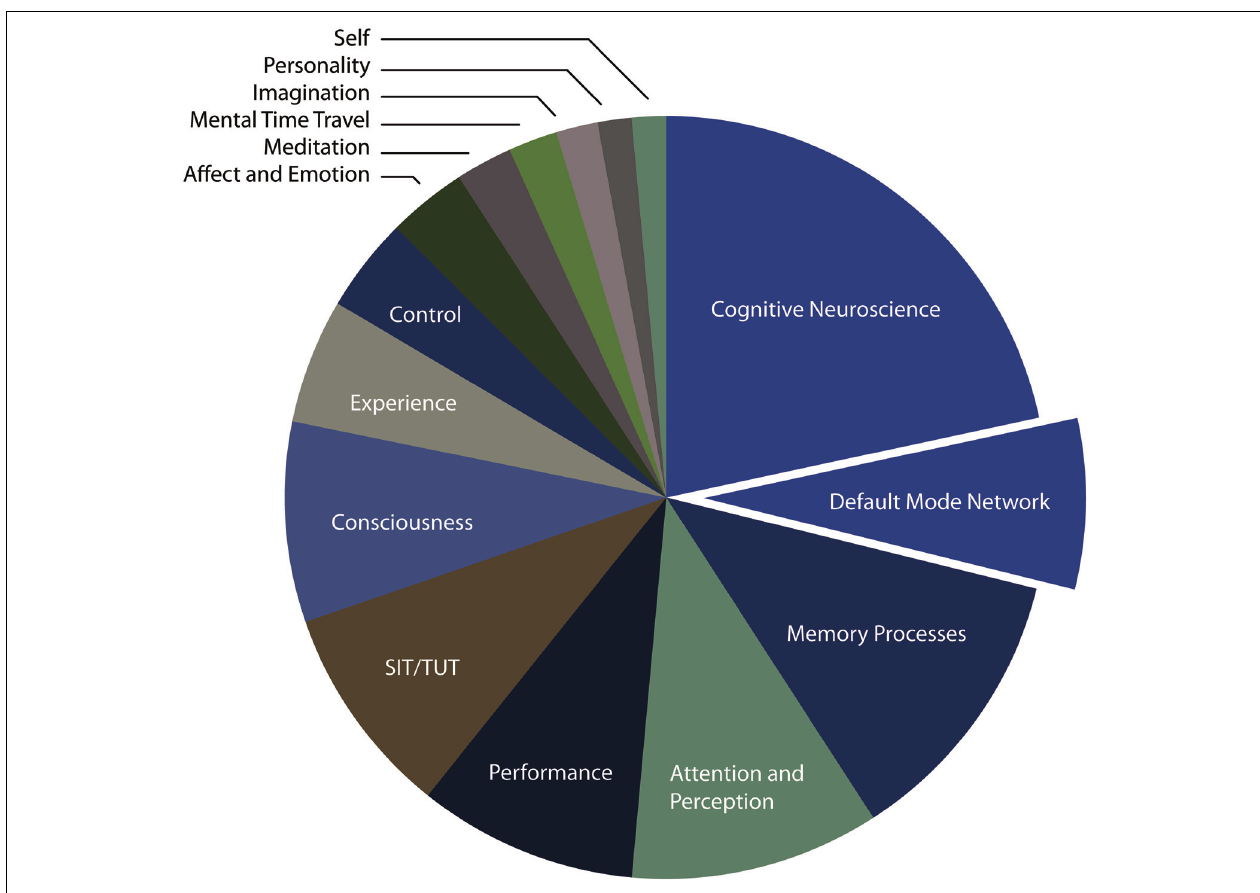
FIGURE 2 | Pie chart illustrating the different categories that form the focus of mind wandering research papers over the last decade. The categories were identified by one author (Jonathan Smallwood), and were